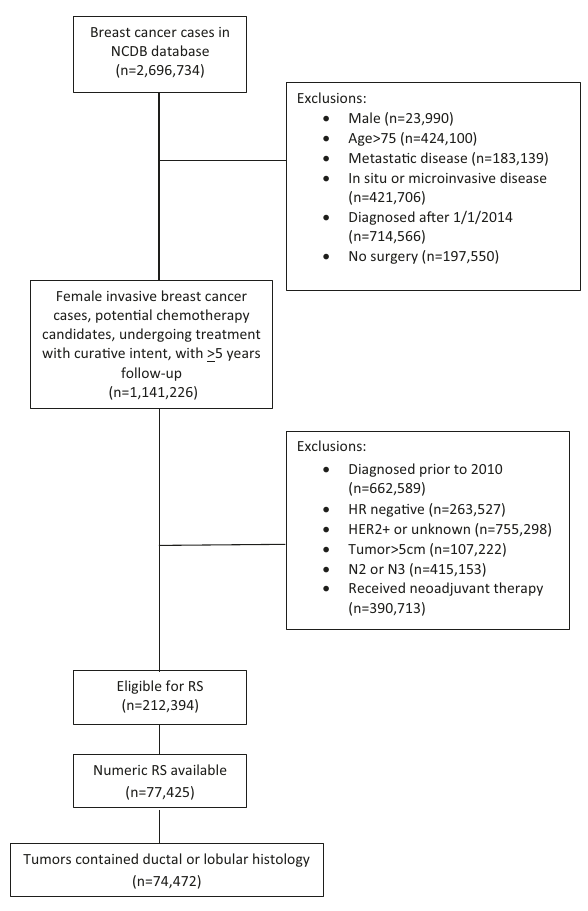
Fig. 1 CONSORT diagram for patient selection. NCDB National Cancer Database, HR hormone receptor, N2, 4 – 9 involved axillary nodes, N3 10 or more involved axillary nodes, RS 21-gene recurrence